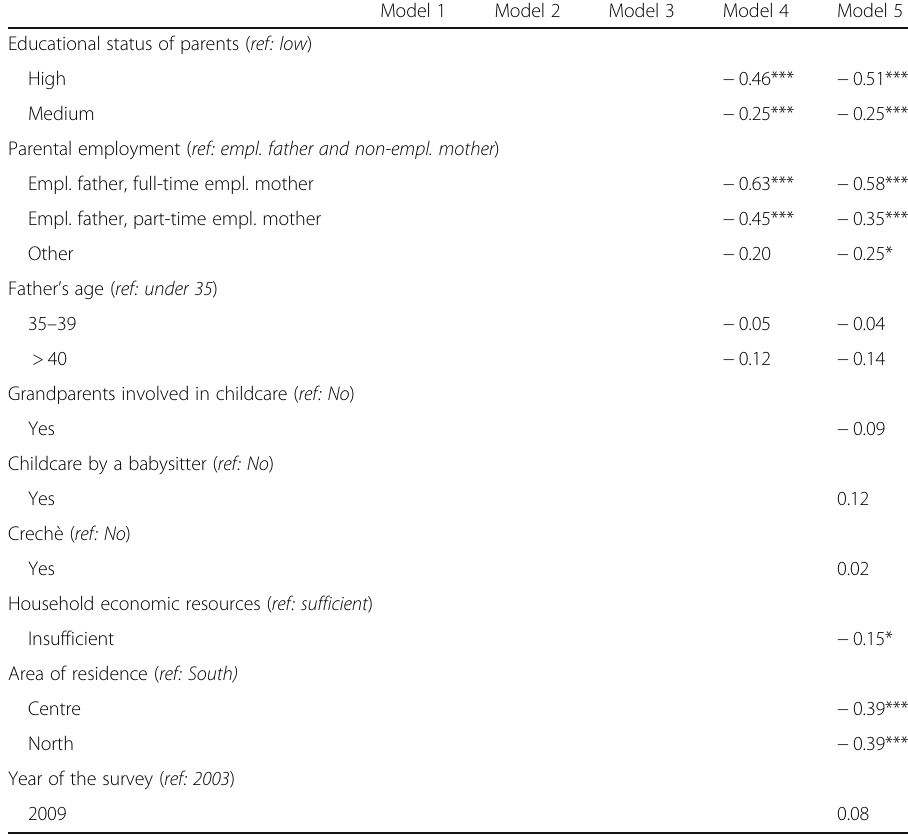
Table 3 Ordinal logistic models for fathers ’ involvement in some childcare activities — β coefficients (coefficients predicting lower involvement of fathers — 3093 observations).